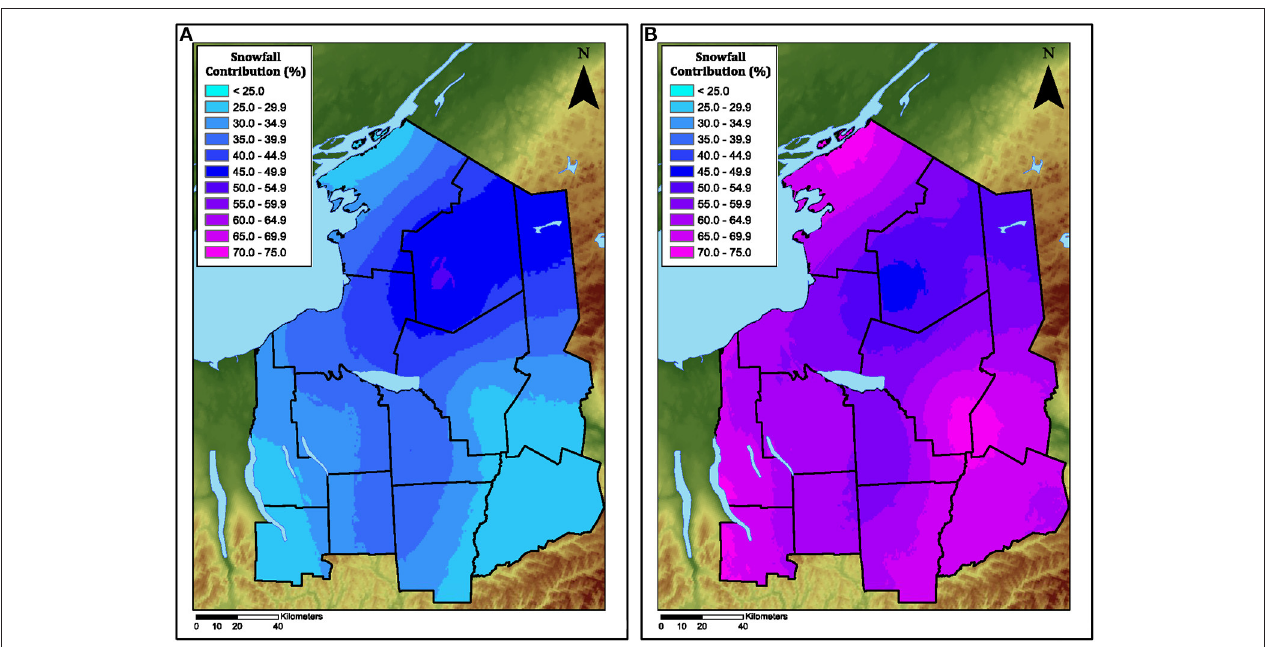
FIGURE 4 | Seasonal snowfall contributions of lake snowstorms (A) and non-lake snowstorms (B) from 1995/96 to